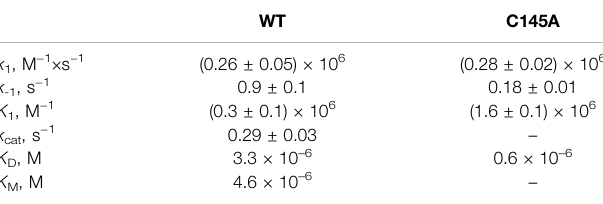
TABLE 2 | Rate constants of the interaction of WT M pro and C145A M pro with the